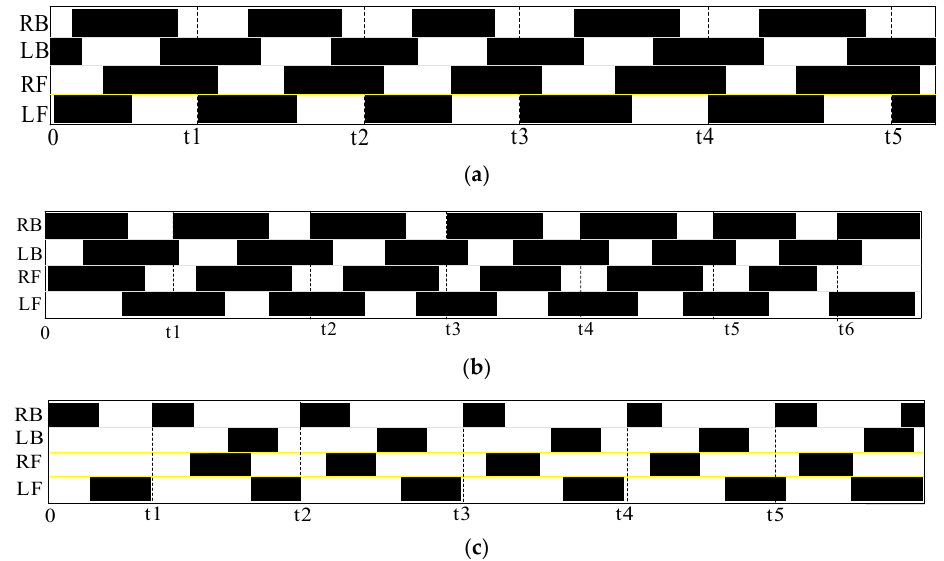
Figure 16. ( a ) The gait phase diagrams of a buffalo; ( b ) the gait phase diagrams of a horse; ( c ) the gait phase diagrams of a dog.